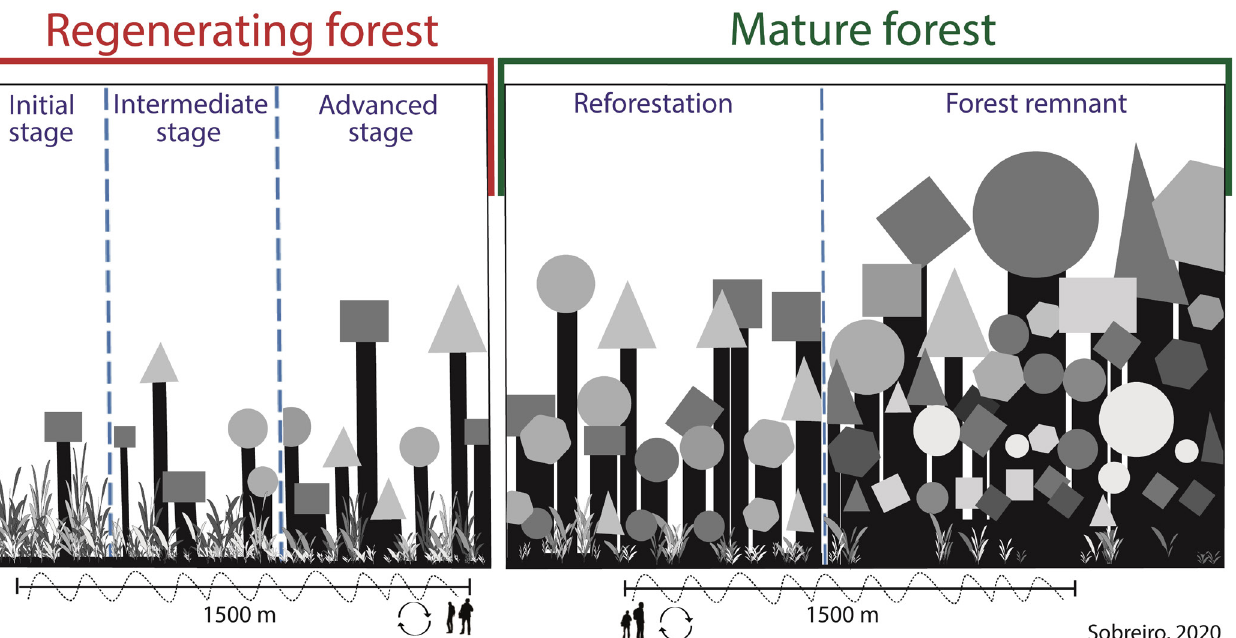
Fig 2 . Experimental design: recursive walks were performed in the continuous forest matrix (mature and regenerating forest) during 12 hours of daily sampling. In each forest, there was a 1500 m transect with six sampling